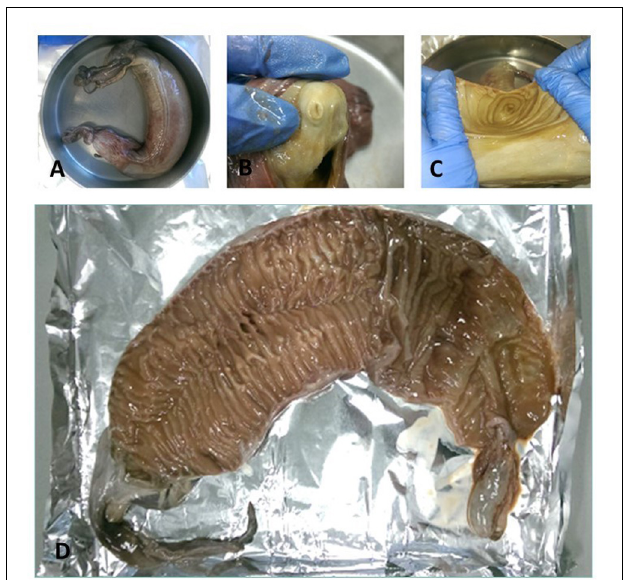
FIGURE 2 | (A) A spiral valve tied with strings, (B) inside opening at the top of spiral valve (duodenum to spiral valve), (C) lower part of the spiral valve cut open as seen from below, (D) one of the test spiral valves cut open from bottom (right) to top (left).